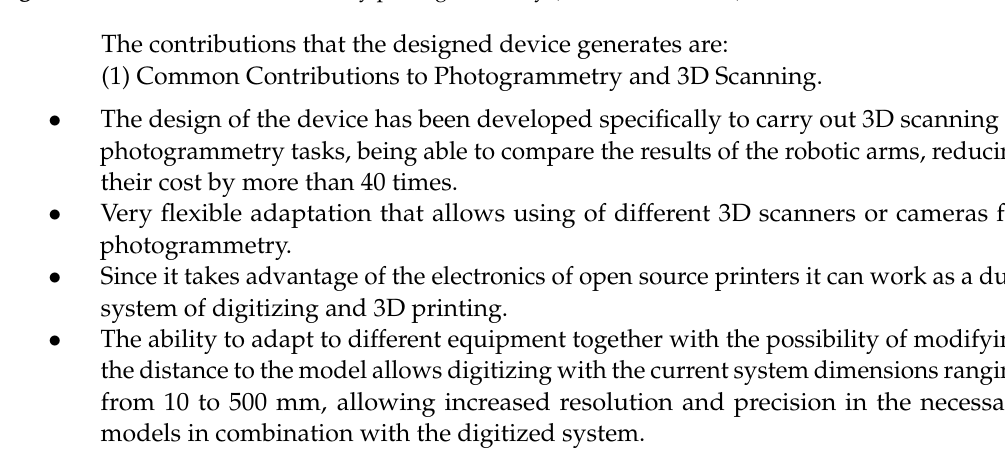
Figure 18. Printed model obtained by photogrammetry (Source: self-made).